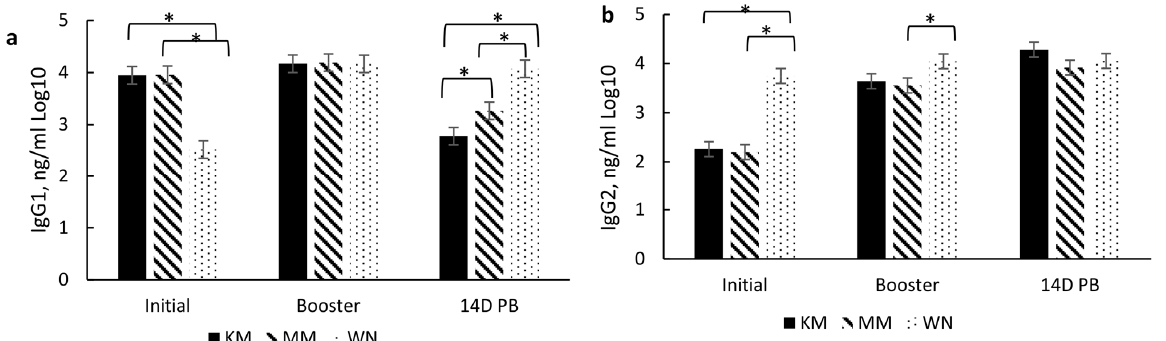
Figure 3. Effect of vaccination treatment by day of vaccination on serum concentrations (ng/ml) of immunoglobulin G1 ( a ) and immunoglobulin G2 ( b ) at initial vaccination, booster vaccination, and 14 days post booster vaccination (14D PB). For the KM and MM treatment groups, D 0 (initial), D